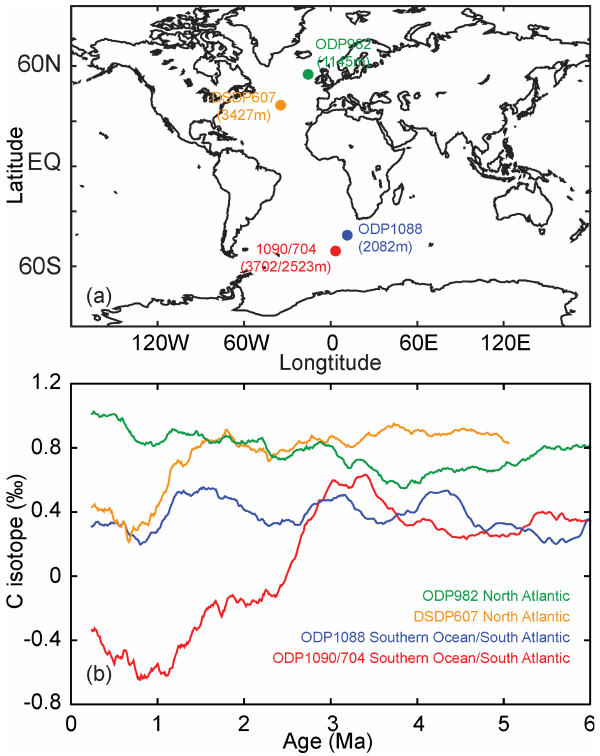
Fig. 1. δ 13 C data in the Atlantic. (a) Site position and depth plotted in a global map. (b) δ 13 C records from Site 982, 607, 1088 and 1090/704. The 13 C data are taken from Hodell and Venz-Curtis (2006), the interpolated and 50-point smoothed 13